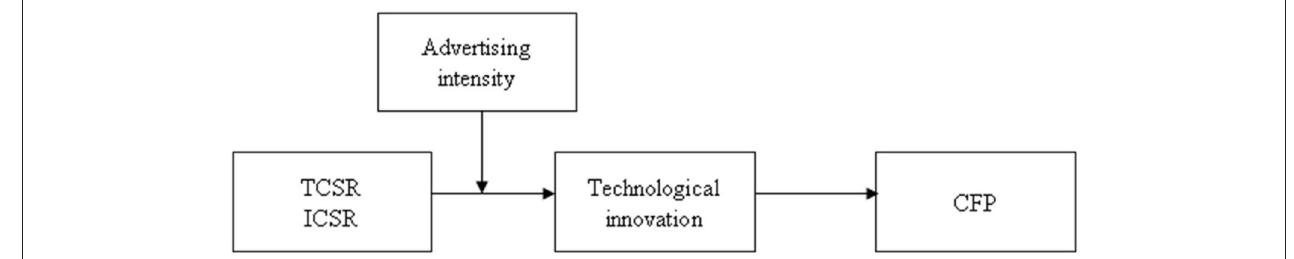
FIGURE 1 | Theoretical